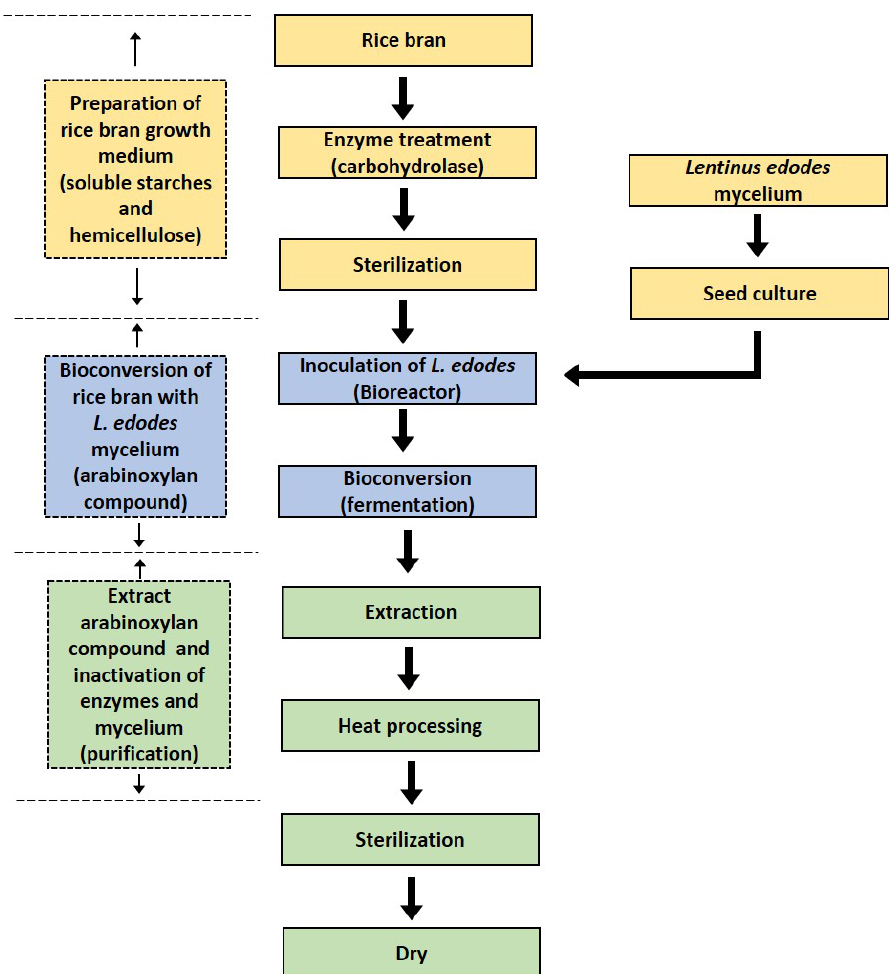
Figure 2. The steps to produce rice bran arabinoxylan compound: (1) Preparation: Defatted rice bran is enzymatically treated and Lentinus edodes is prepared as a seed culture. (2) Bioconversion: Inoculation of L. edodes as a bioreactor to instigate fermentation. (3) Extraction: The arabinoxylan compound is extracted through heat processing, sterilization and